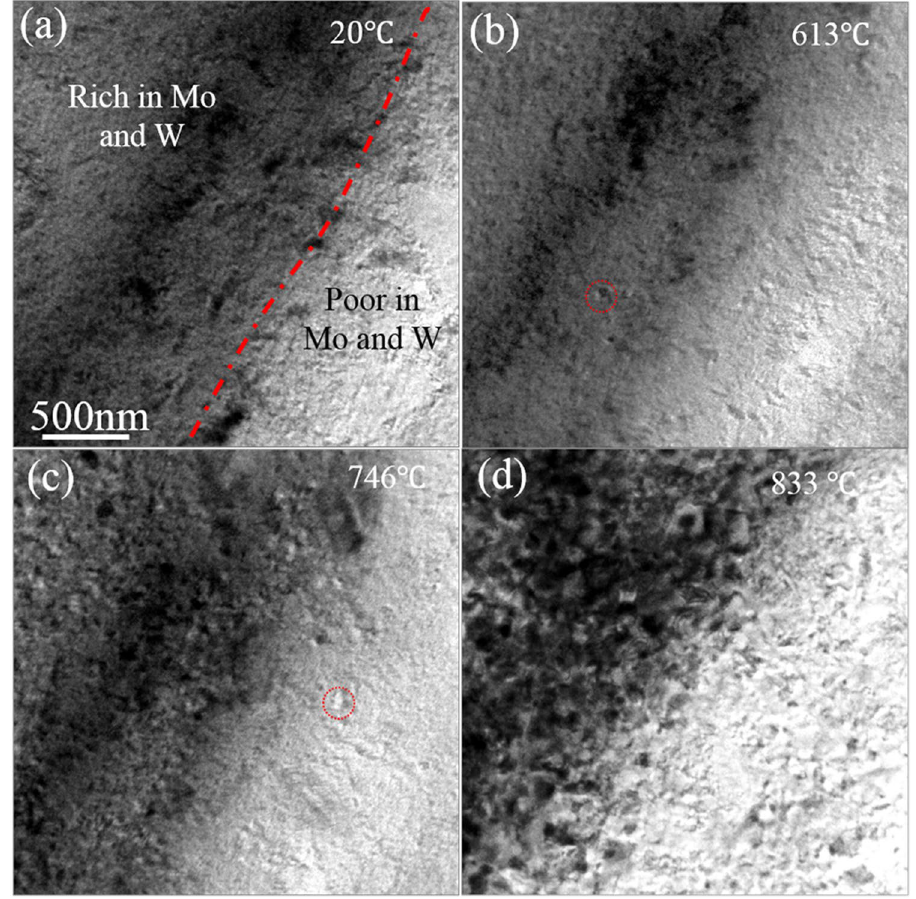
Figure 6. In-situ heating TEM-BF images of cold rolled Ti-9Mo-6W alloy: ( a ) as cold-rolled state, ( b ) after heating 154 seconds when reading temperature was up to 613 °C, ( c ) after heating 182 seconds when the specimen holder temperature was up to 746 °C, and ( d ) after heating 201 seconds and the specimen holder temperature was up to 833